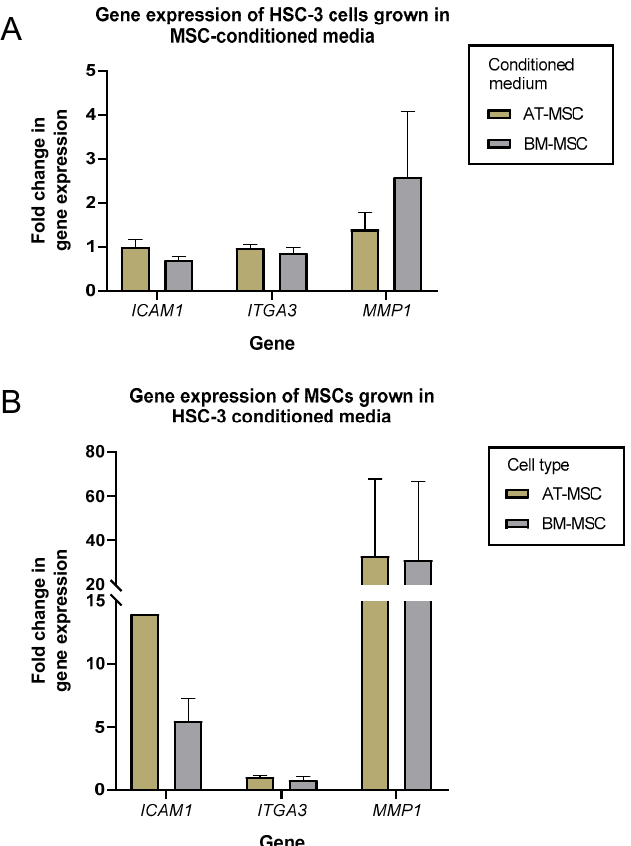
Figure 3. ICAM1 , ITGA3 and MMP1 gene expression of HSC-3 and MSCs cells were mainly unaffected when cultured in MSCs- or HSC-3-conditioned media. HSC-3 cells were grown in (AT- and BM-) MSCs-derived conditioned media ( A ), while AT-MSCs and BM-MSCs were grown in HSC-3-derived conditioned media ( B ). RNA was isolated from cells and reverse-transcribed to cDNA, then analyzed for changes in gene expression of ICAM1 , ITGA3 and MMP1 . Fold-change values were normalized to expression levels of the same cells grown in serum-free